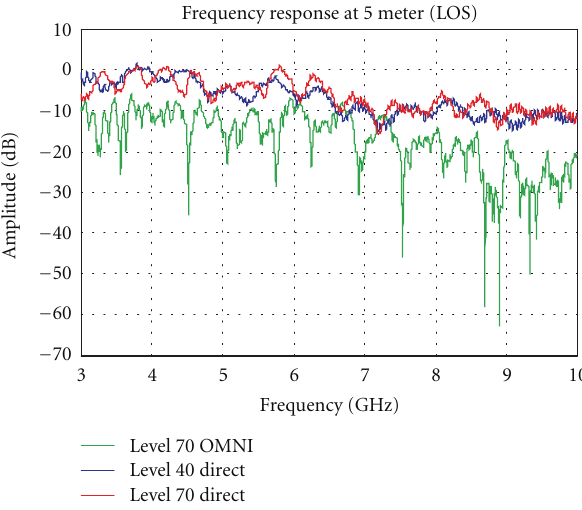
Figure 4: Amplitude of frequency response at 5